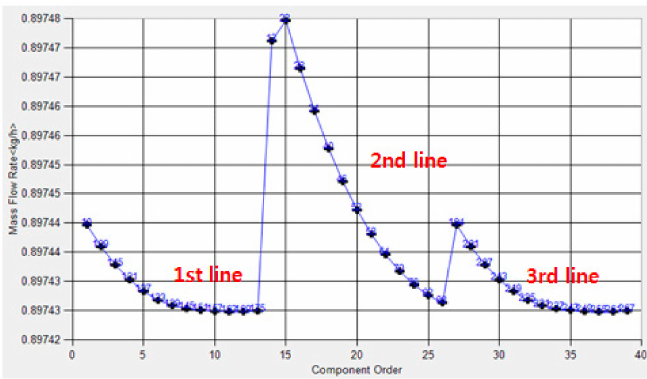
Figure 5. Distribution of LPG mass flow rate at 39 burners in a module, modeled as in Figure 4.